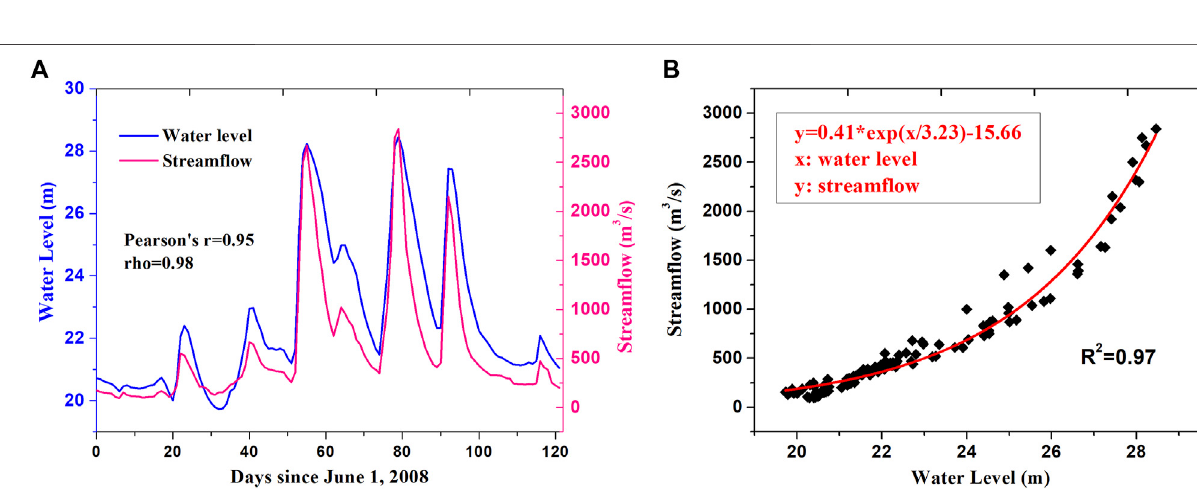
Frontiers in Earth Science |